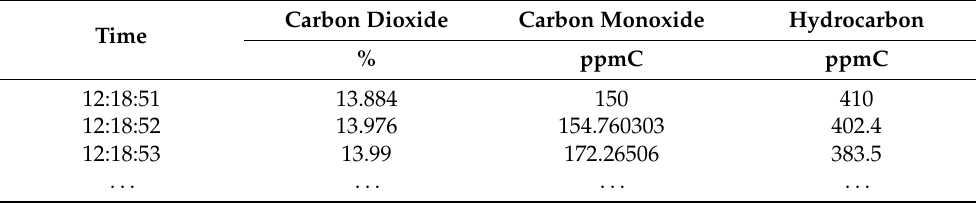
Table A1. Sample table of carbon compound contents in automobile exhaust gas.